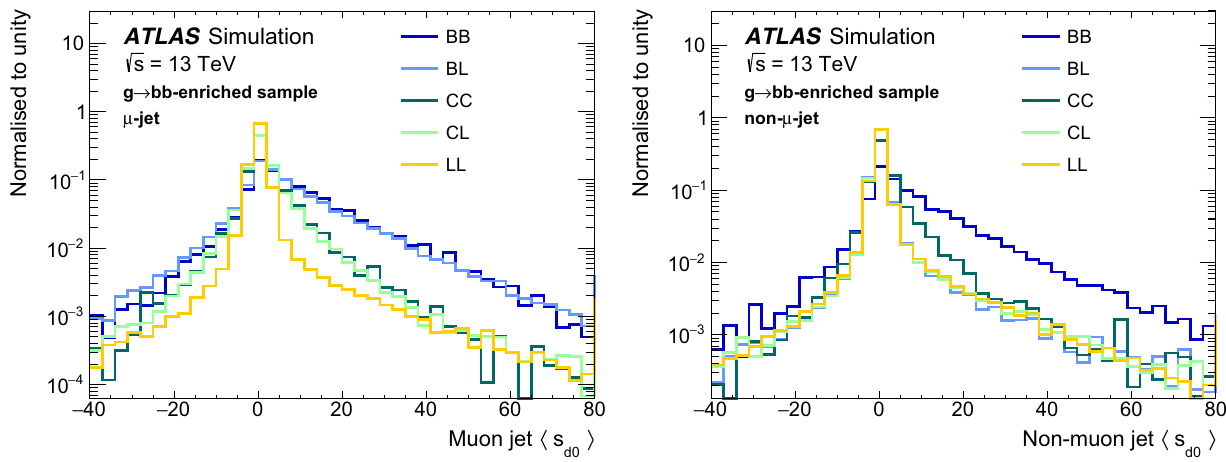
(cid:5) (cid:4) s d , distributions for the muon (left) and non-muon jets (right) inclusive in j trk μ and j trk non- μ 0